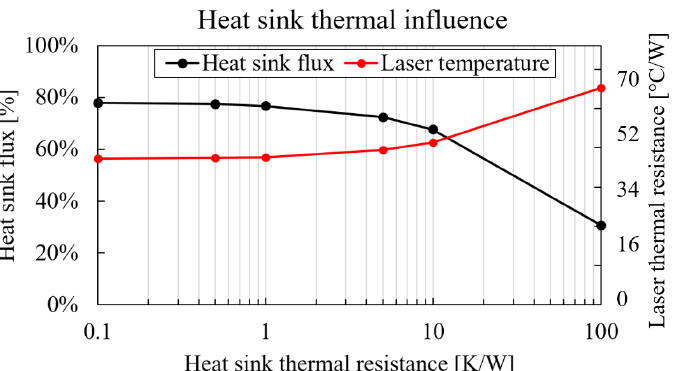
Figure 13. Laser thermal resistance (temperature, red) and heat sink flux (black) as a function of heat sink thermal resistance.